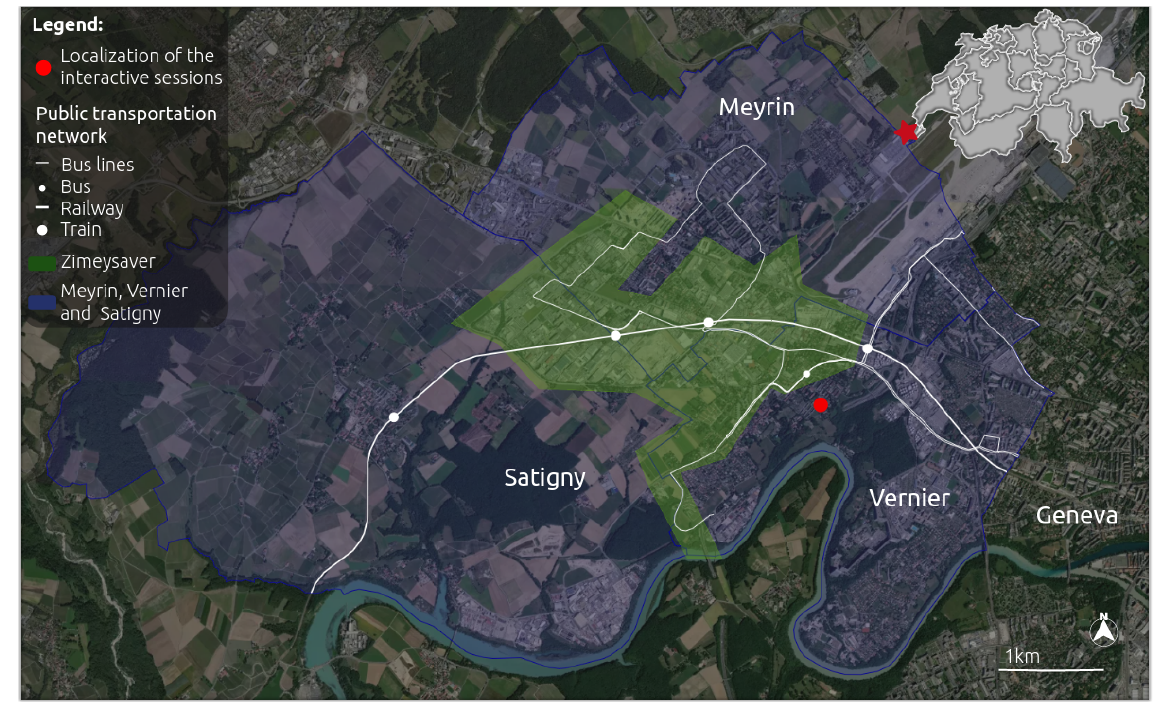
Figure 4. Contextualization of the interactive sessions designed for the